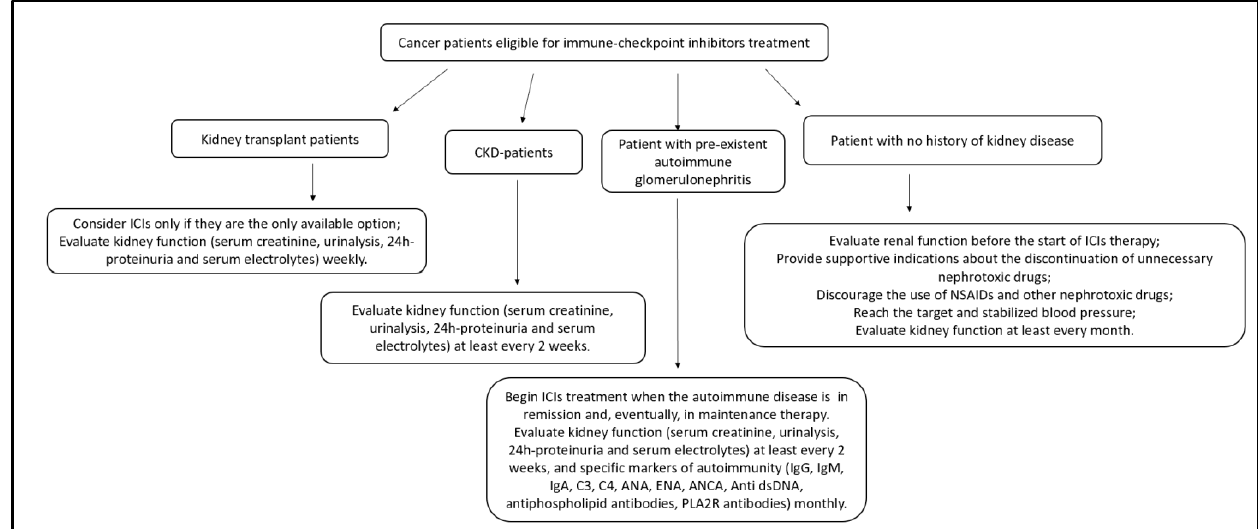
Figure 3. Suggested approach in the initial evaluation of the cancer patients eligible for immune checkpoint treatments. Legend: CKD, chronic kidney disease; ICIs, immune checkpoint inhibitors; IgG, immunoglobulin G; IgM, immunoglobulin M; IgA, immunoglobulin A; C3, complement C3;